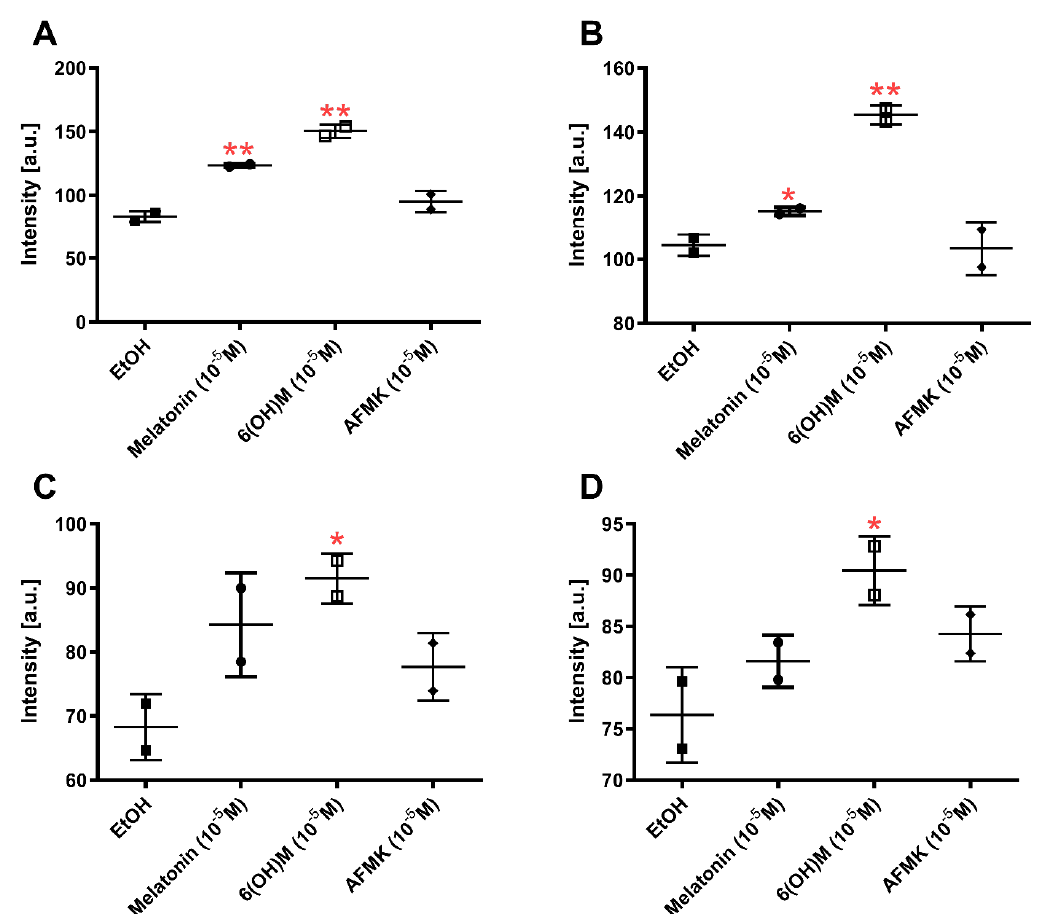
Figure 4. Profile of cytokine expression for melatonin, AFMK and 6-hydroxymelatonin after 24 h incubation in HEKn as results of Proteome Profiler Cytokine Array: ( A ) MIF, ( B ) IL1ra, ( C ) SERPINE1, and ( D ) CXCL1 protein expression. The plots represent all values with calculated means and significance was evaluated by Mann–Whitney U test with * p < 0.05 and ** p < 0.01.